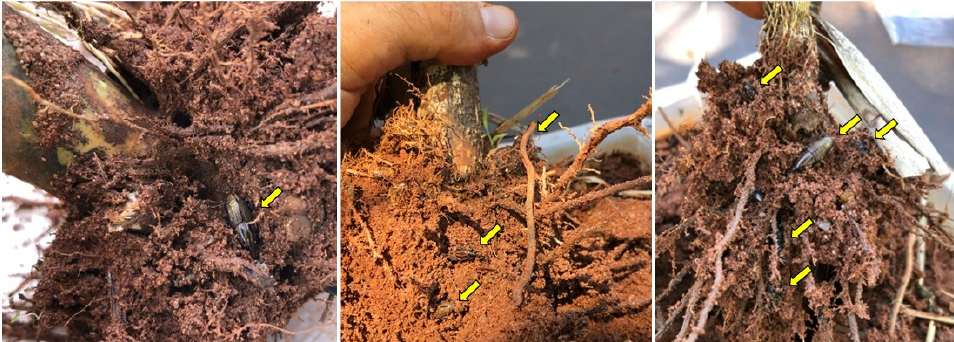
Figure 10. Sphenophorus levis adults attached to sugarcane rhizomes and roots. Yellow arrows indicate S. levis adults.